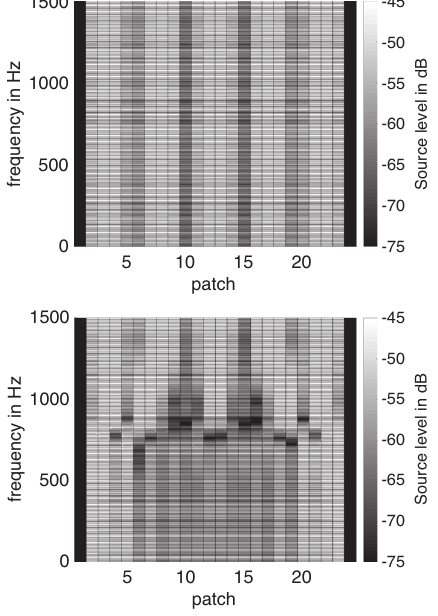
Figure 19. Comparison of the original source distribution along the 24 patches (upper) given by (16) and the reconstructed source distribution (lower) as function of frequency for N p = 5. Reconstruction based on far- fi eld receiving positions.